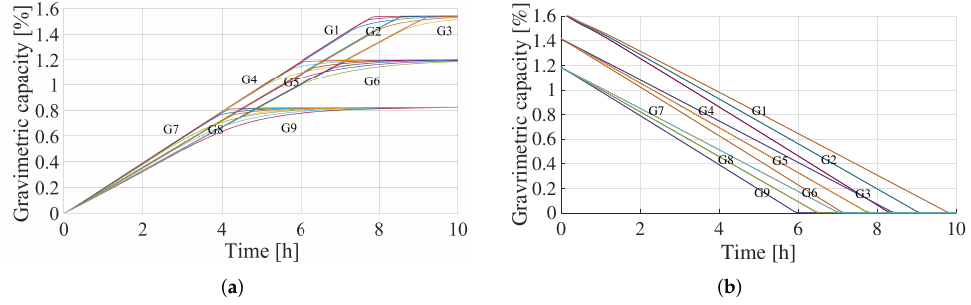
Figure 11. Gravimetric capacity as a function of time: ( a ) Absorption process, ( b ) Desorption